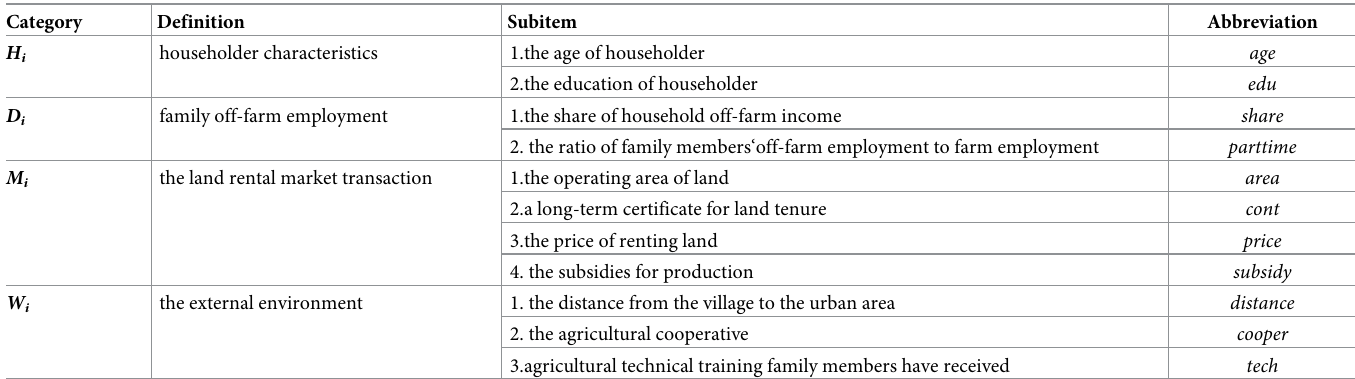
Table 1. Definition of relevant indicators of households’